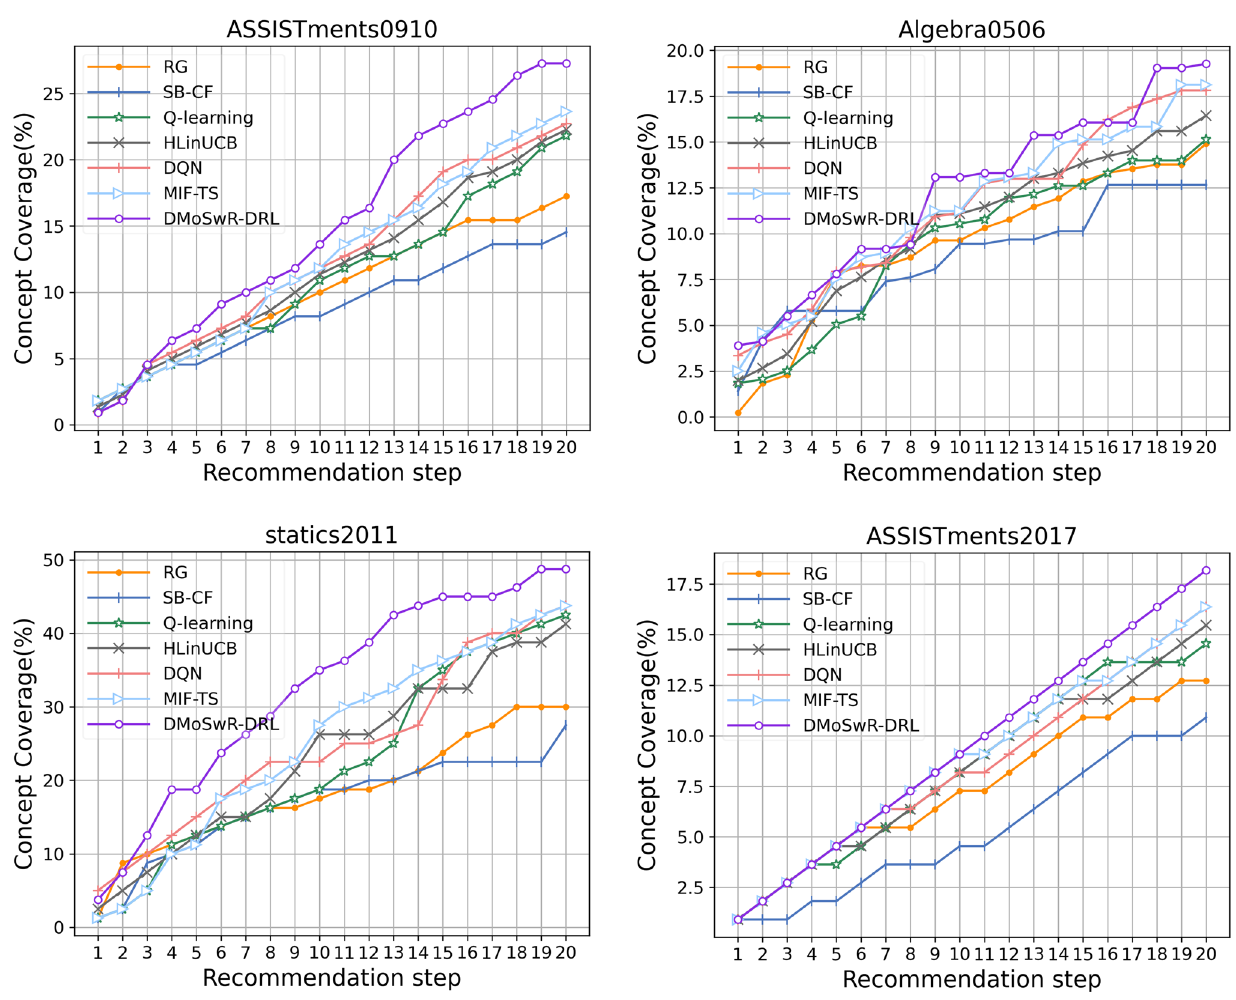
Fig. 9 Performance comparison of different models on four datasets in terms of